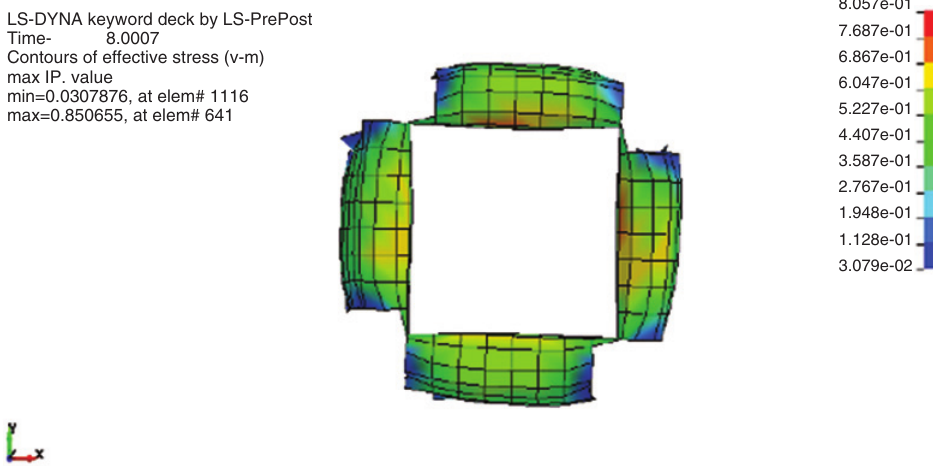
Figure 4 Contour plot of Von Mises stress of stacking sequence [45/-45/0/90/90/0/-45/45]s.